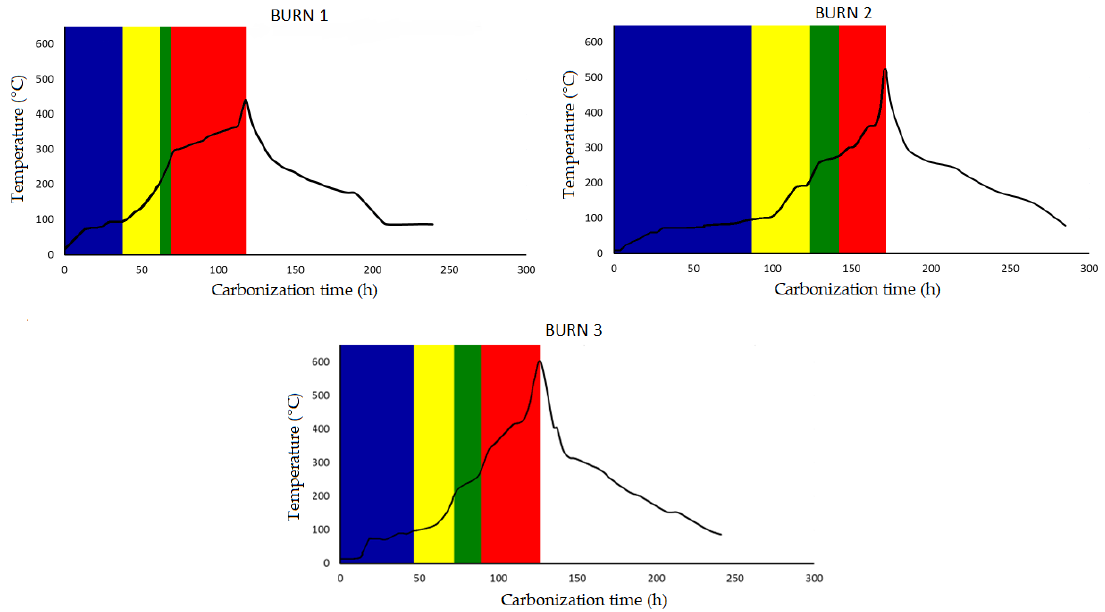
Figure 6. Heating ramps during carbonization in three burnings of Brazilian beehive kilns. Blue color = phase 1, yellow color = phase 2, green color = phase 3, red color = phase 4, white color = phase 5. This carbonization process includes the following species: Madrone, White oak, and Red oak. Table 3. Burning time and heating ramps on each phase during carbonization in Brazilian beehive kilns.